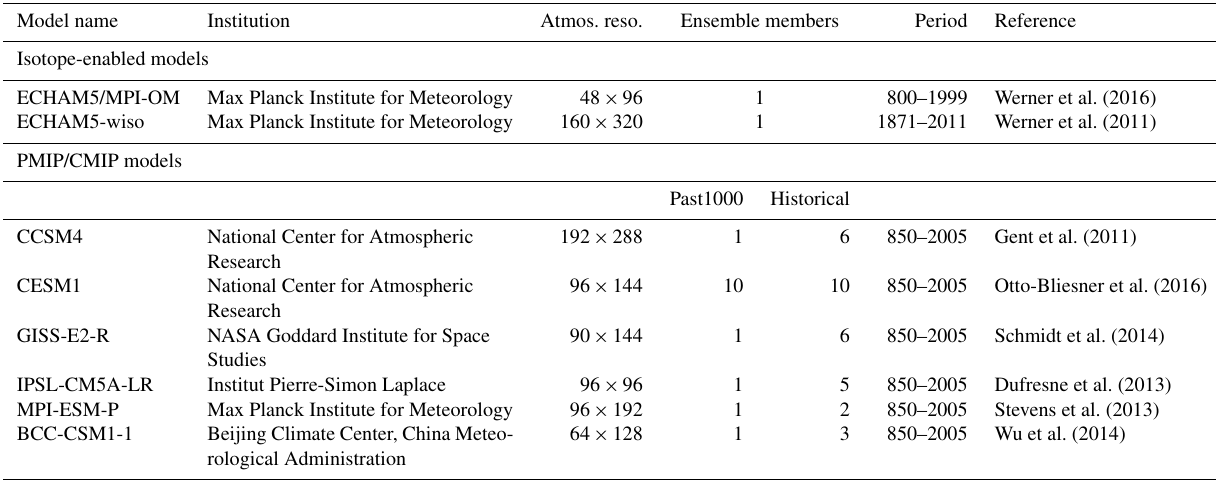
Table 1. Modeling centers, parameters and references of the climate models used in this study. “Past1000” and “Historical” refer to PMIP/CMIP experiments covering the 850–1850CE and 850–2005CE periods,